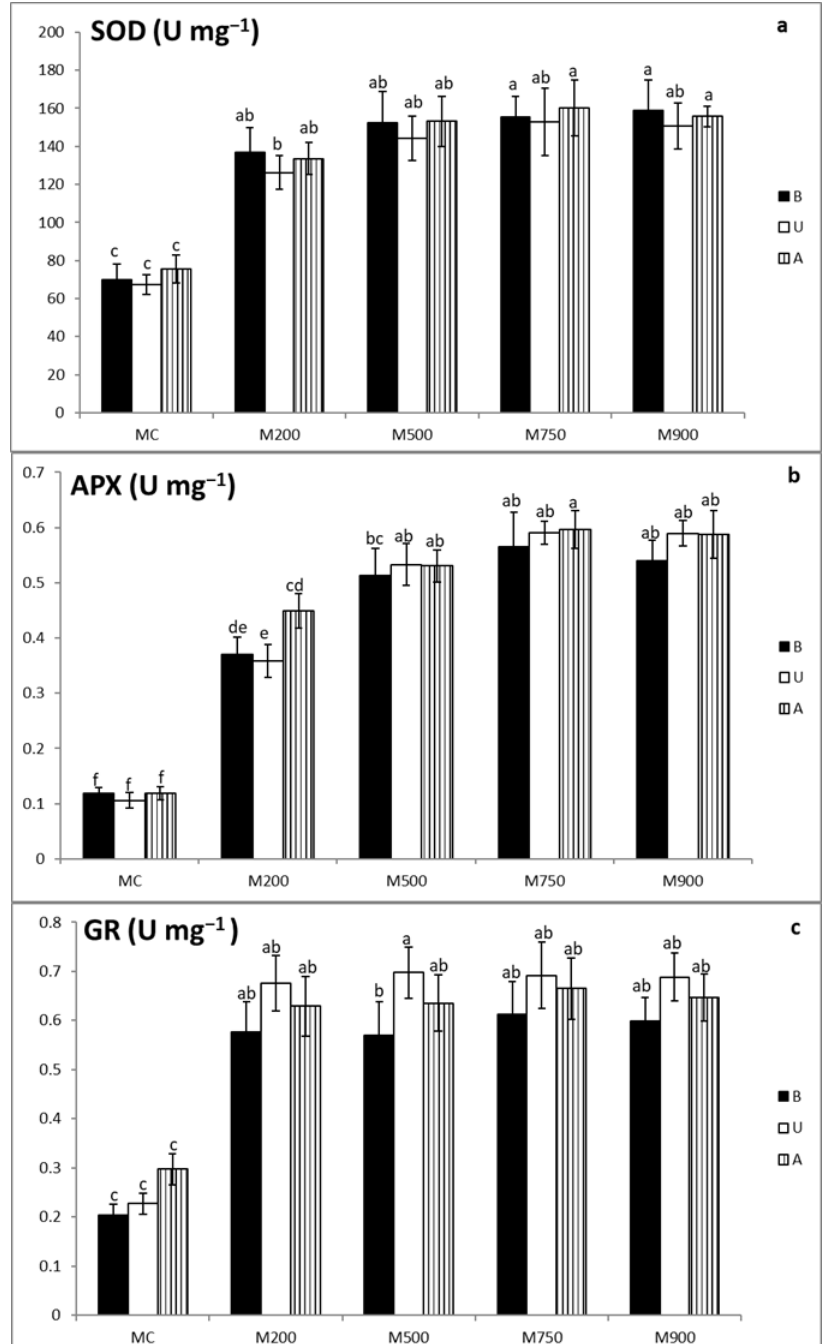
Figure 1. SOD (a) APX (b) and GR (c) activities in the leaves of three different Figure 1. SOD ( a ) APX ( b ) and GR ( c ) activities in the leaves of three different miscanthus cultivars miscanthus cultivars (B, U, and A) cultivated in soils with gradient TE (B, U, and A) cultivated in soils with gradient TE concentrations (MC-control, M200, M500, M750, concentrations (MC-control, M200, M500, M750, and M900). Values are and M900). Values are presented as means ± SD. Different letters refer to significant differences presented as means ± SD. Different letters refer to significant differences between plants (Turkey HSD test, n = 5, p ≤ between plants (Turkey HSD test, n = 5, p ≤ 0.05).